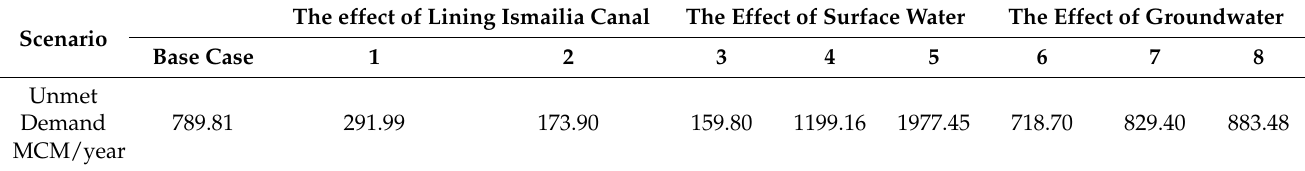
Table 17 and Figure 20 show the comparison between the base case and different cases. Table 17. Yearly unmet demands